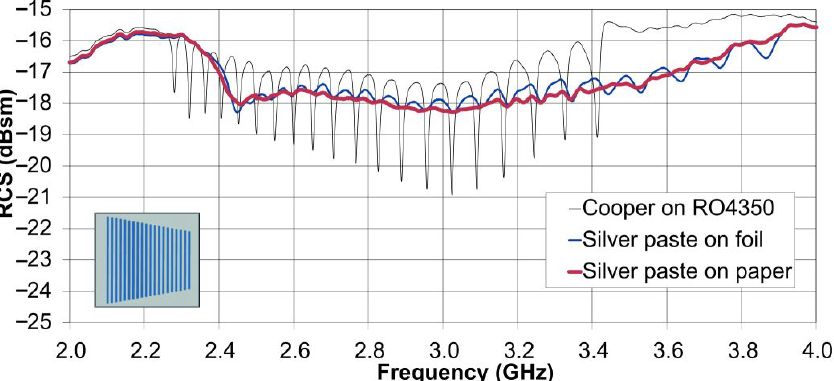
Figure 15. Measured RCS of an array of detuned planar dipoles closely coupled to a rectangular metallic plate manufactured by the screen-printing technology on Folanorm polyester film and a paper substrate compared to a standard copper-on-microwave substrate technology.